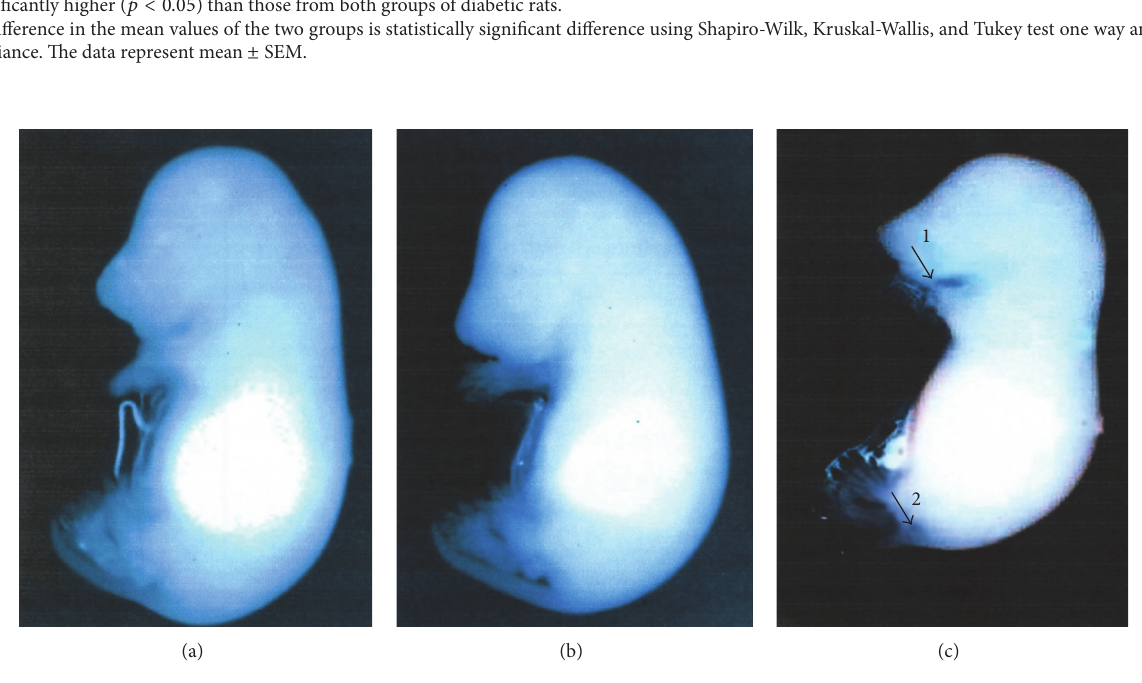
Figure 1: (a) Control fetus, (b) nonmalformed fetus of diabetic rat, and (c) malformed fetus of diabetic rat. Arrows indicate the position of malformation (1: short mandible, 2: short